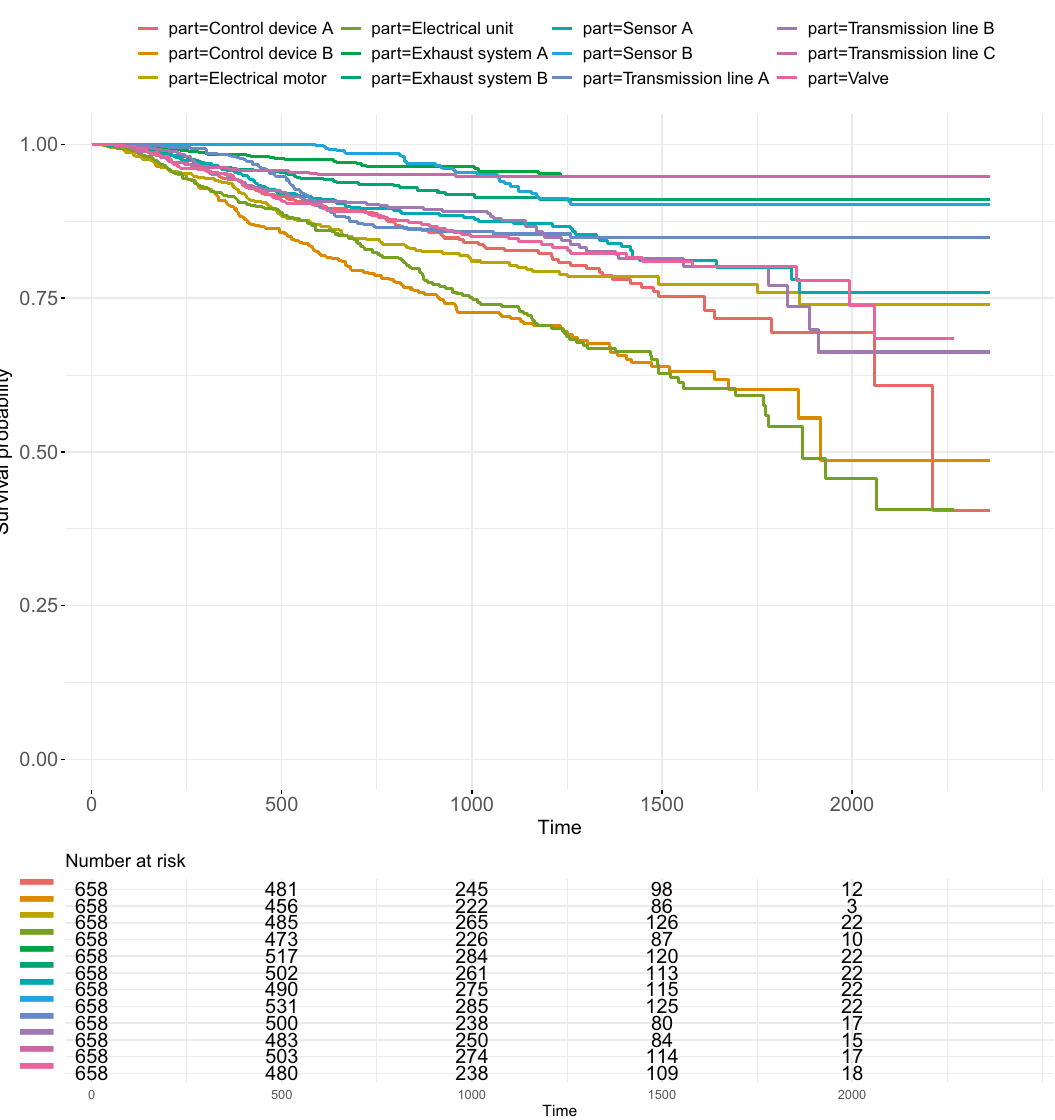
Figure 6. Survival curves for 12 machine components (top). The numbers at risk (bottom) give the total number of components that haven’t experienced the failure yet remaining at the different time stamps. This includes both uncensored and right-censored